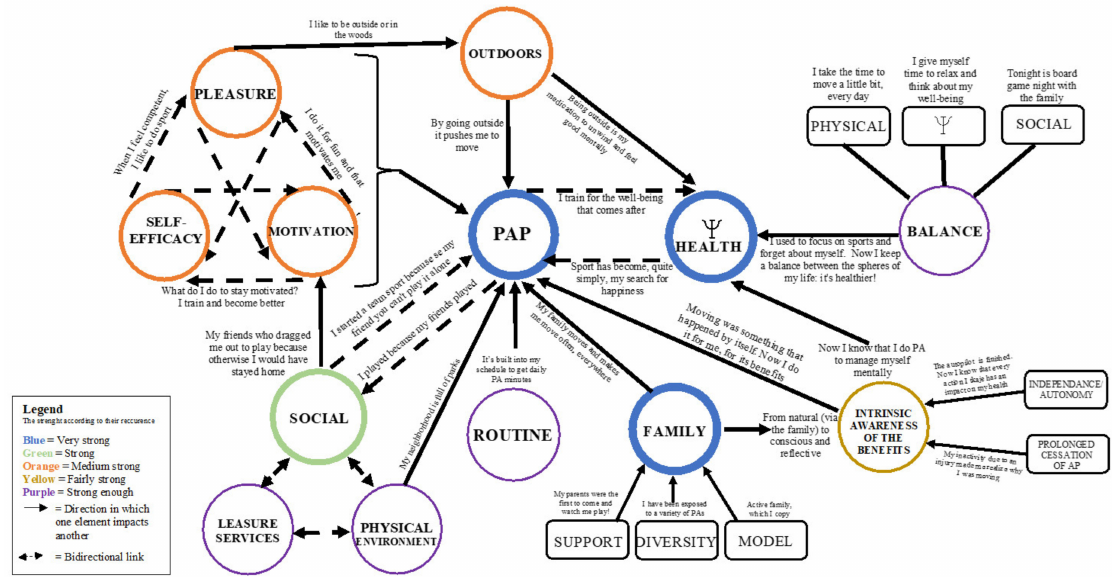
Figure 5. Summary of the winning conditions for the adoption and maintenance of healthy lifestyle